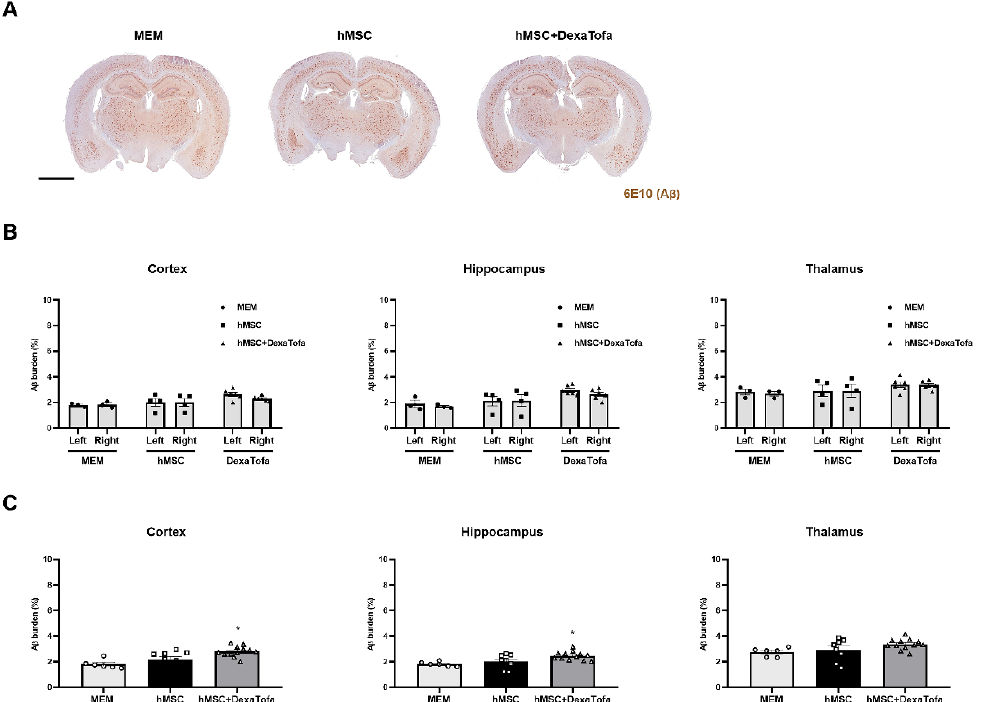
Figure 6. Assessment of changes in amyloid deposition in the cortex, hippocampus, and thalamus. ( A ) Representative 5xFAD brain tissue sections acquired from the following groups: MEM ( n = 3), hMSC, and hMSC ( n = 4) + DexaTofa ( n = 6) were stained using the 6E10 antibody to examine differences in amyloid burden (dark brown precipitate) among the groups. Scale bar: whole brain = 2 mm. ( B ) The amyloid burden of the left and right hemispheres was evaluated first in the following three regions: hippocampus, and thalamus. Significant differences between the hemispheres were not noted for all three regions. mean ± SEM (two-way ANOVA, Tukey’s multiple comparison). ( C ) Data acquired from the left and right hemispheres were combined for each of the three regions. Out of the three groups, the hMSC + DexaTofa group displayed the highest level of amyloid deposition for all three regions. Statistical significance is defined as * p < 0.05 vs. hMSC; mean ± SEM (one-way ANOVA, Dunnett’s multiple comparison).